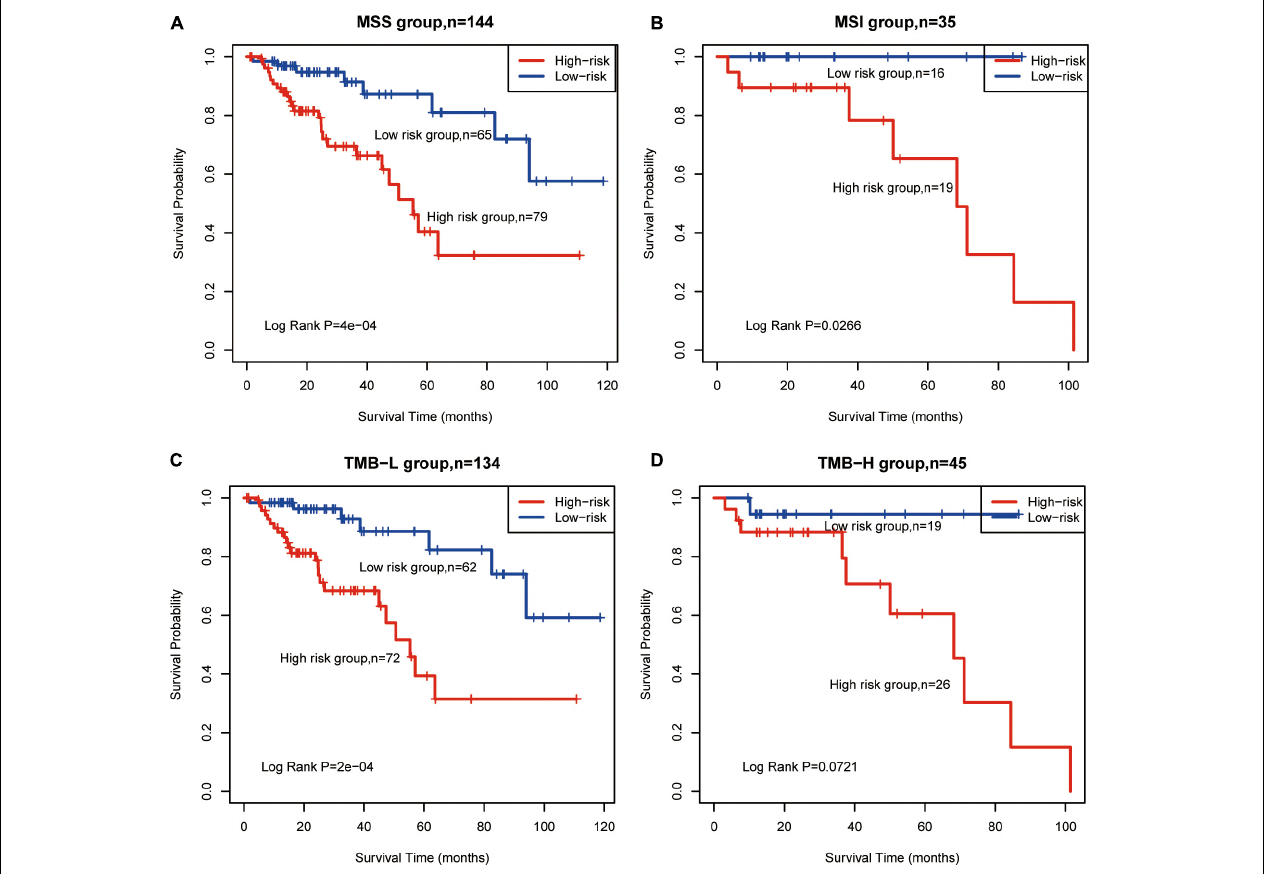
FIGURE 4 | Survival prediction for TMB and MSI subtypes using the methylated signature. Based on Kaplan–Meier survival curves, patients with (A) MSS, (B) MSI, (C) TMB-L, and (D) TMB-H were classified into high- and low-risk groups using the methylated signature. Vertical hash marks indicate censored data. MSS, microsatellite stable; MSI, microsatellite instability; TMB-L, low tumor mutational burden; TMB-H, high tumor mutational burden.